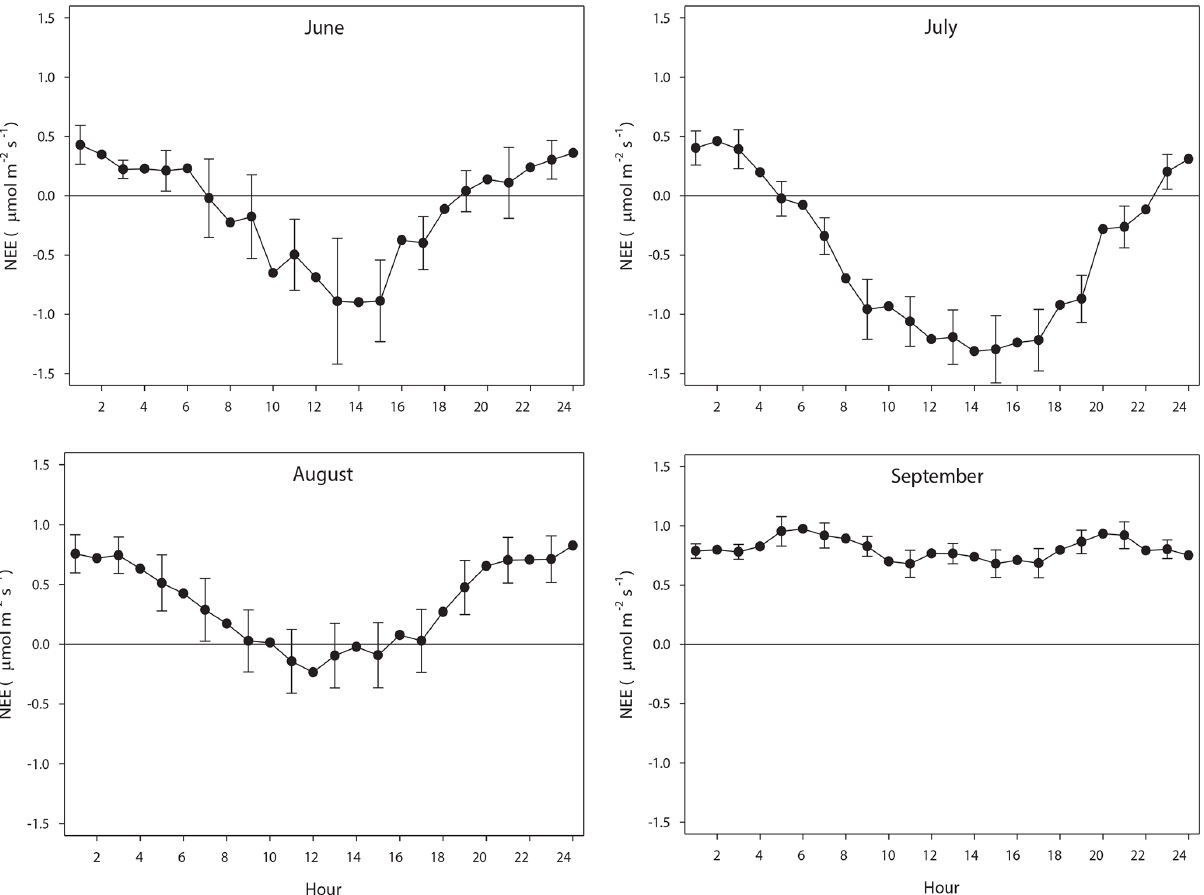
Figure 8. The mean monthly diurnal course of net ecosystem exchange (NEE) during the period of eddy covariance measurements 25 June to 17 September. The error bars (every 2nd shown) are the 95% confidence interval. Notice that the main part of August was gap filled because of measurement problems.